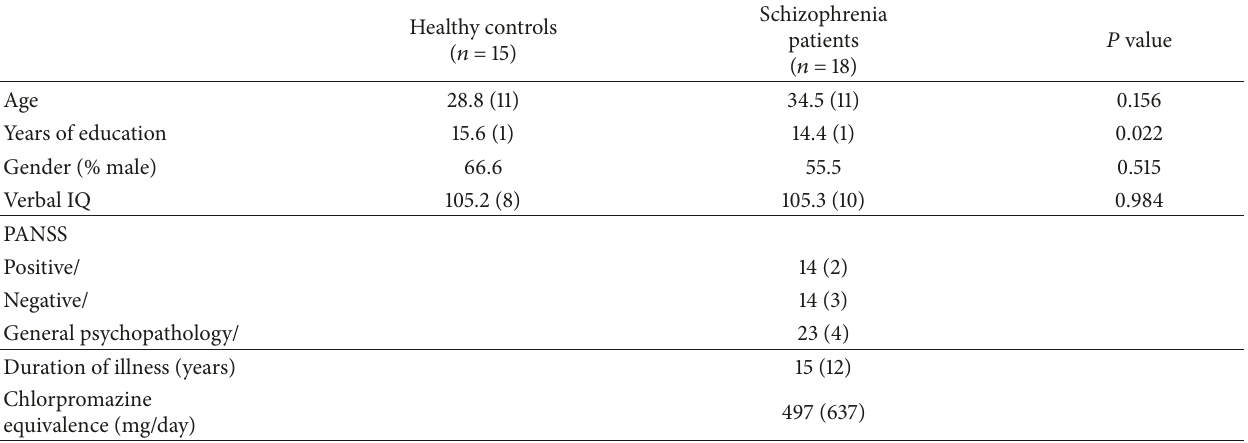
Table 1: Sociodemographic and clinical data in the two groups of